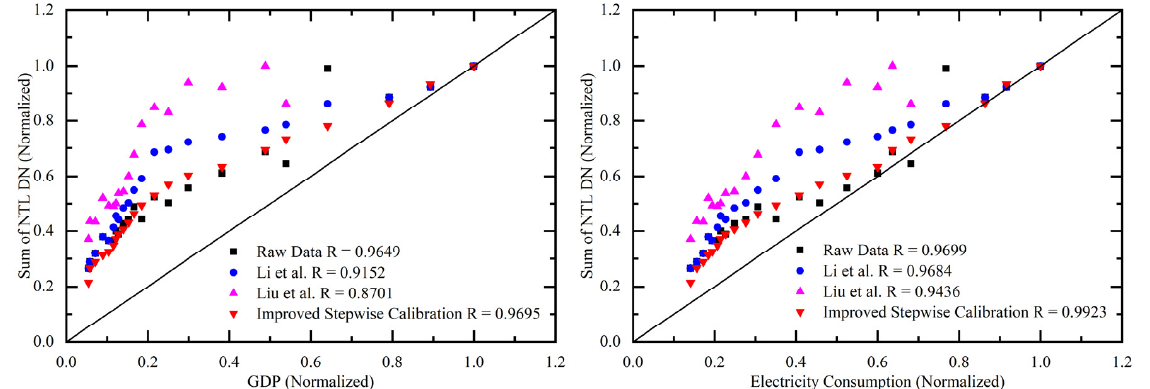
Figure 13. Comparison of the correlation of regional nighttime light data in China obtained by different correction methods with GDP and EC.